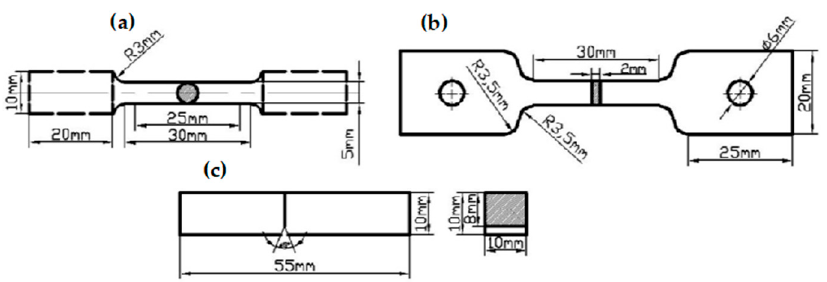
Figure 1. Schematics of the specimens: ( a ) rod specimens; ( b ) dog-bone-shaped flat specimens; and ( c ) full-sized V-notch Charpy specimens.